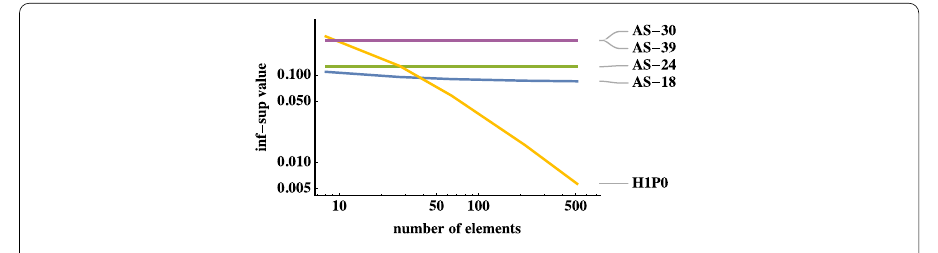
Fig. 4 Inf-sup test: numerical evaluated inf-sup constant over the number of elements